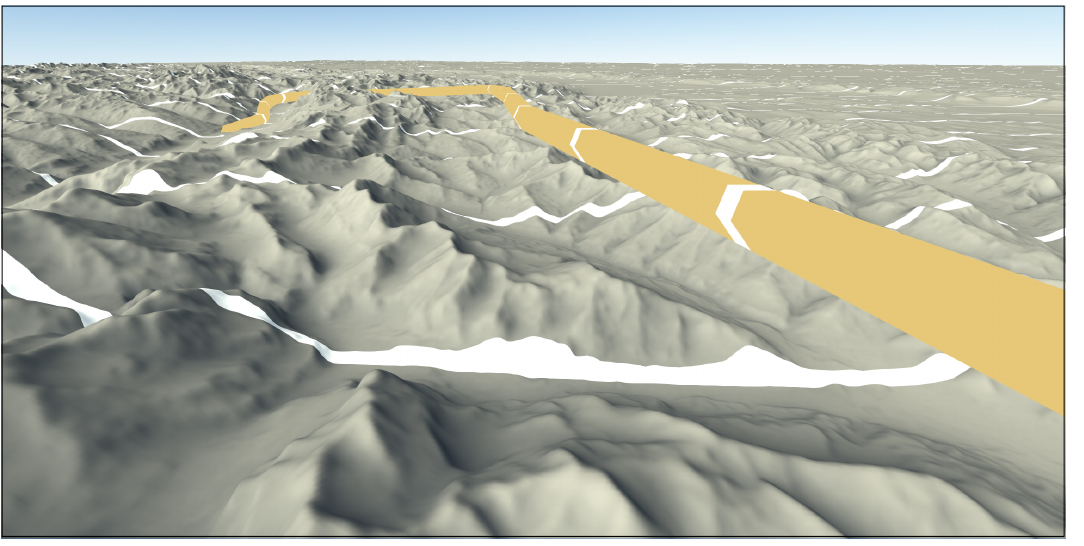
Figure 13. Using horizontal lines along the scene to emphasize distances. The white lines on the terrain and on the trajectory have the same distance to the